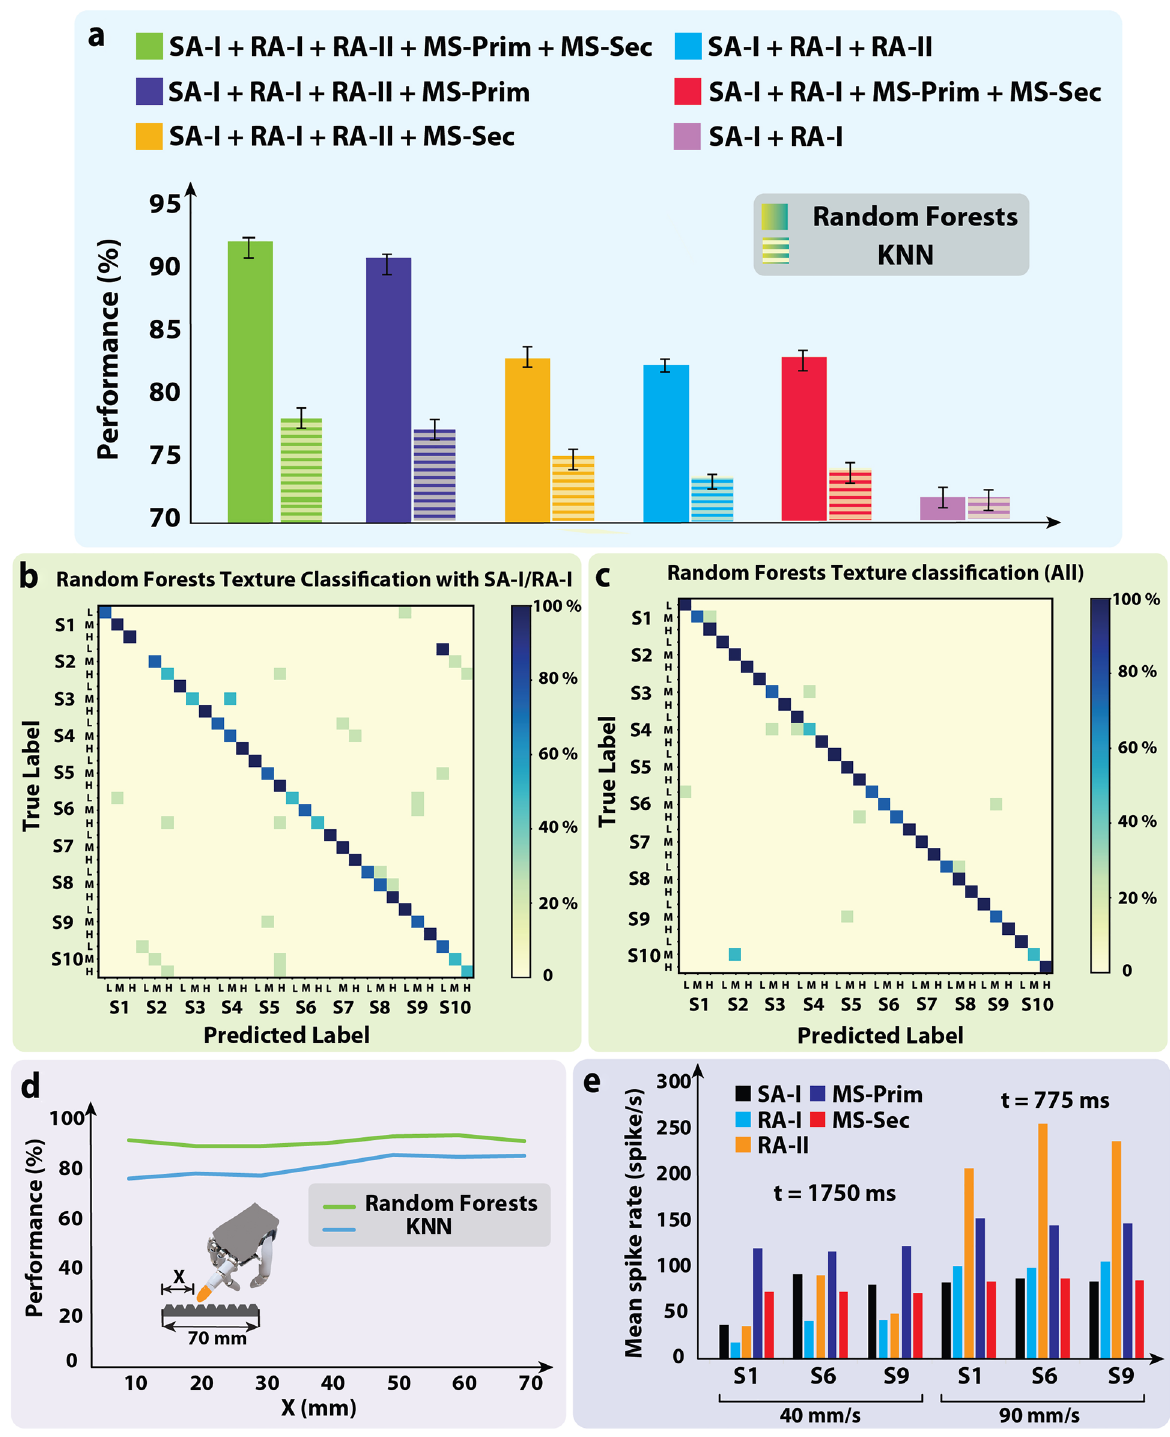
Figure 5. Contribution of the skin mechanoreceptors and muscle spindles in texture discrimination. ( a ) Classification accuracy for each SA-I/RA-I/RA-II/MS-Prim/MS-Sec population and their combination for all textures based on the spike rate algorithm for KNN and RF classifiers. ( b ) Confusion matrix for classifying 10 textures with 6 scanning speeds only for SA-I and RA-I afferents using Random forests classifier. ( c ) Confusion matrix for classifying 10 textures with 6 scanning speeds for integration of all mechanoreceptors and muscle spindles using Random forests classifier. ( d ) Classification performance for different lengths of finger’s displacement on the surface for KNN and Random forests classifiers. ( e ) The mean spike rate of mechanoreceptors and muscle spindle afferents during the response to three naturalistic surfaces (S1, S6, and S9) under two scanning speeds (slowest, 40 mm/s, and fastest, 90